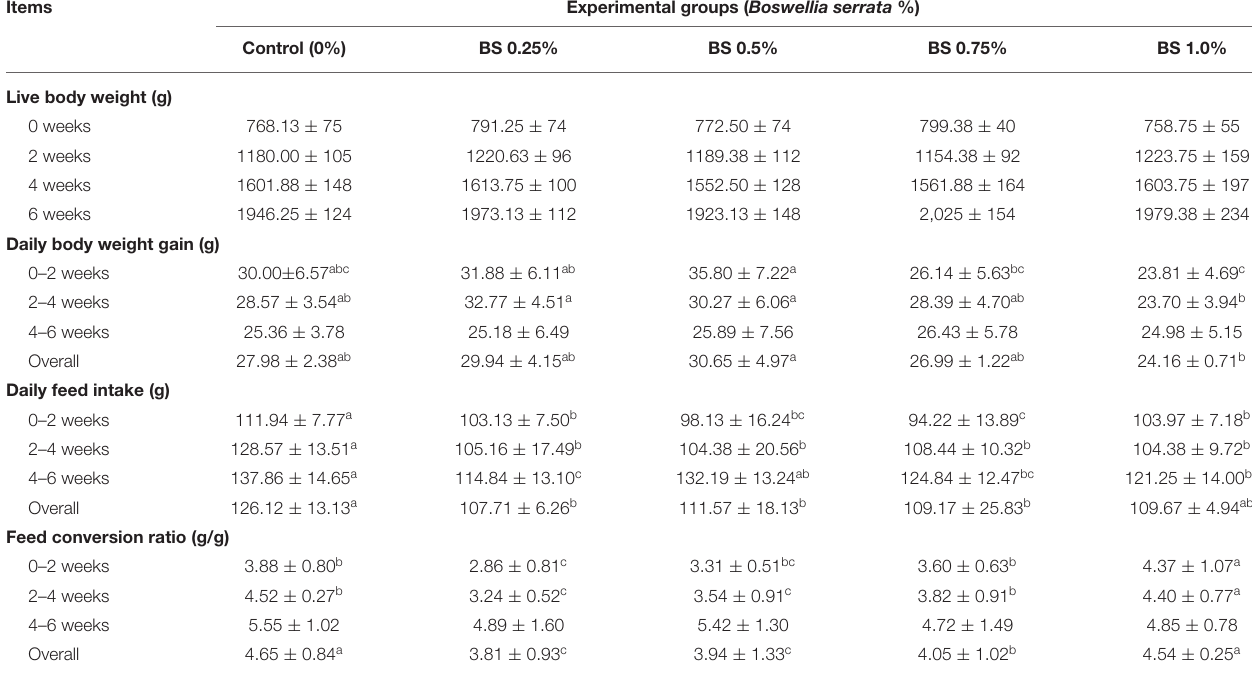
TABLE 2 | Effect of Boswellia serrata on growth performance parameters of NZW rabbits.